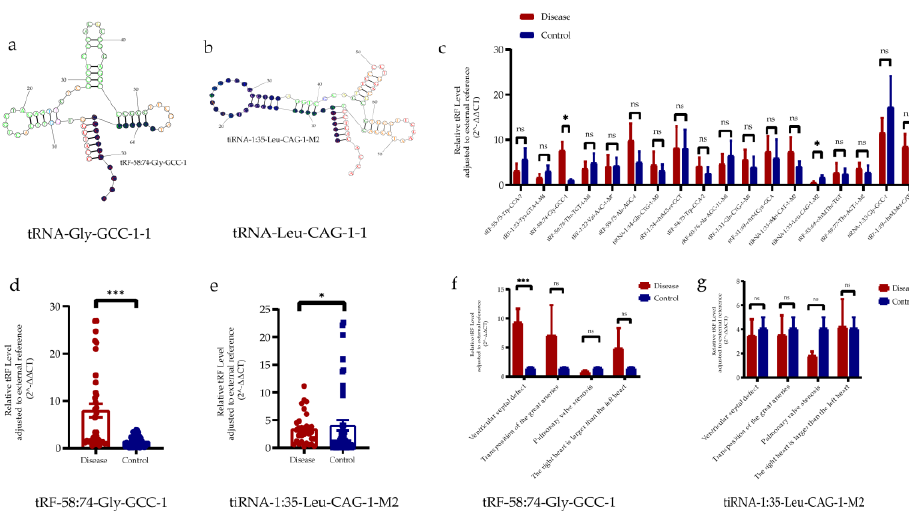
Figure 3. Verification of 2 regulatory anomalies tRFs/tiRNAs in pregnant women with abnormal fetal heart and normal fetal hearts. ( a , b ) The position of each tRFs/tiRNAs on the shamrock secondary structure derived from tRNA is shown. tRFs/tiRNAs expression in serum of pregnant women with abnormal fetal heart and normal fetal hearts was analyzed by qRT-PCR. All data were analyzed by Student ’ s t test. The asterisk indicates how significant the difference between the groups is (* p < 0.05, *** p < 0.001). ( c ) Verification of 18 tRFs/tiRNAs (12 Disease vs. 12 Control). ( d ) Verification of tRF-58:74-Gly-GCC-1 (35 Disease vs. 48 Control). ( e ) Verification of tiRNA-1:35-Leu-CAG-1 M2 (35 Disease vs. 48 Control). ( f , g ) Verification of tRF-58:74-Gly-GCC-1 and tiRNA-1:35-Leu-CAG-1 M2 for certain CHD defects.